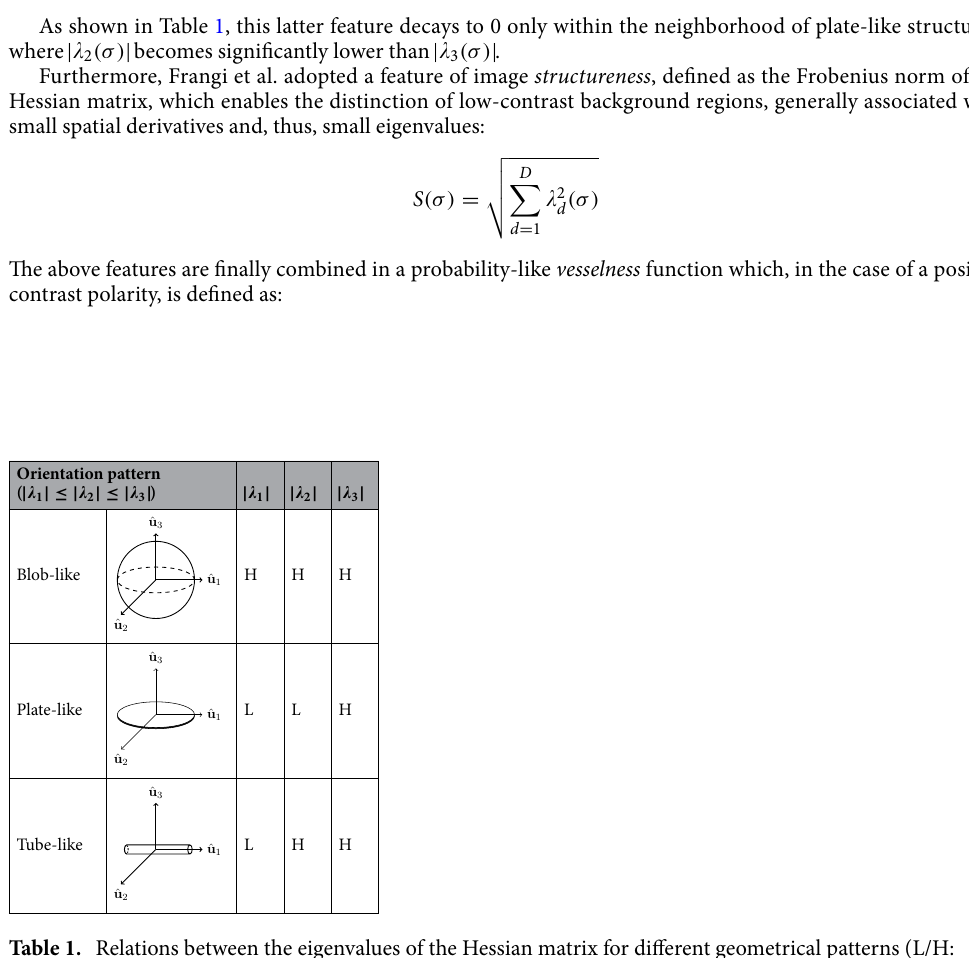
Table 1. Relations between the eigenvalues of the Hessian matrix for different geometrical patterns (L/H: low/high absolute value; adapted from 37 ). ˆ u i denote the normalized eigenvectors related to the ith eigenvalue. Tubular structures are characterized by large-magnitude (cid:31) 2 and (cid:31) 3 eigenvalues and by a small dominant (cid:31) 1 ; the sign of (cid:31) 2 and (cid:31) 3 is determined by the contrast polarity (negative for a positive contrast, i.e. light objects against a dark